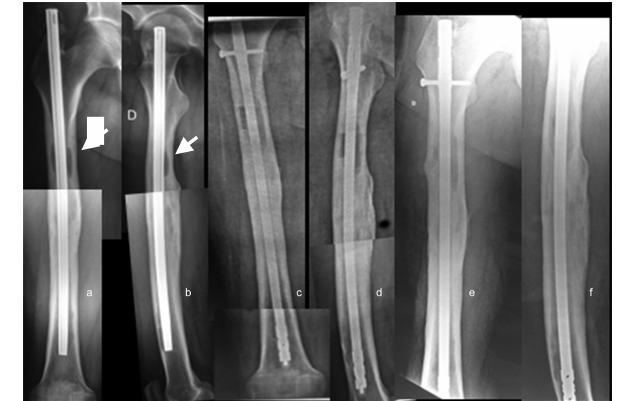
Figure 3. (a, b) AP and lateral radiographs of a patient with a history of open femur fracture treated with an endomedullary nail, 15 years of evolution. The patient had an active fistula at the level of the middle third of the external aspect of the thigh. Note the in- tracanal pathological images (white arrows). (c, d) AP and lateral radiographs 2 months postoperatively, after treatment with the com- mercial nail. (e, f) Control radiographs 48 months postoperatively with infection